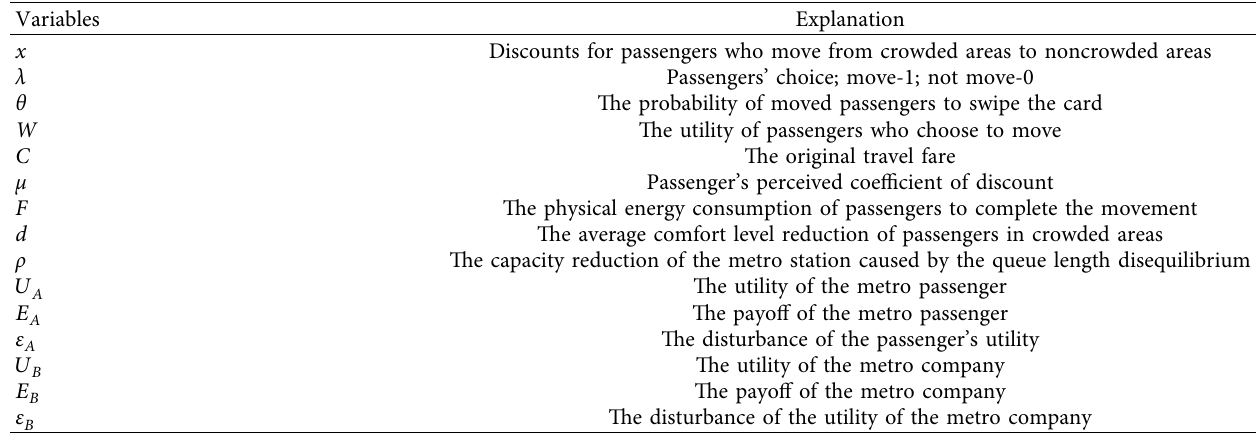
Table 1: Variables in the utility analysis.